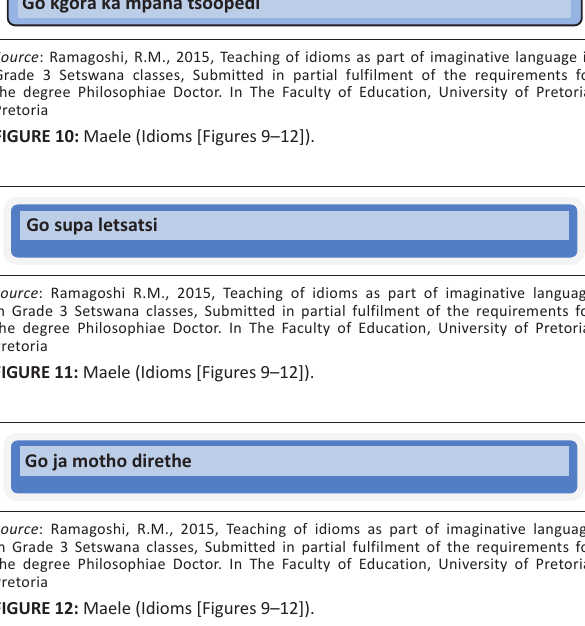
FIGURE 12: Maele (Idioms [Figures 9–12]).